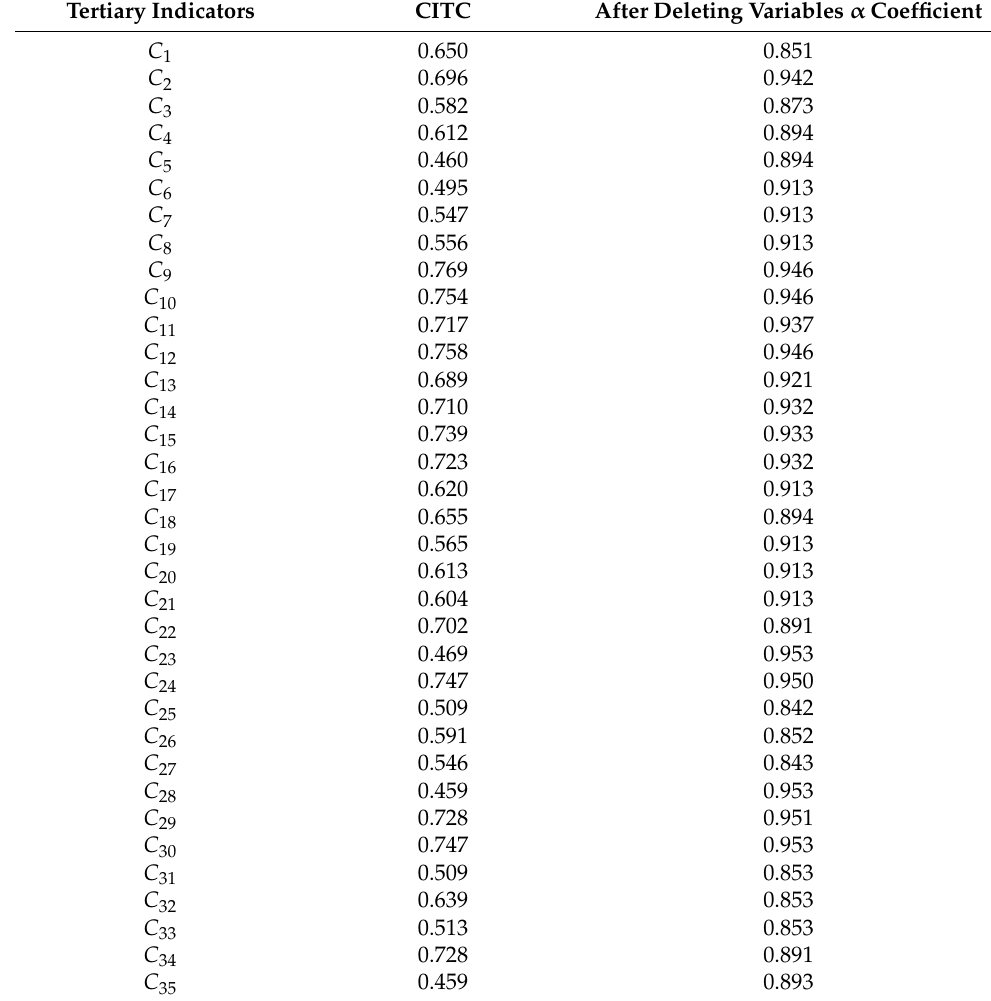
Table 4. Reliability test results of initial indicators.